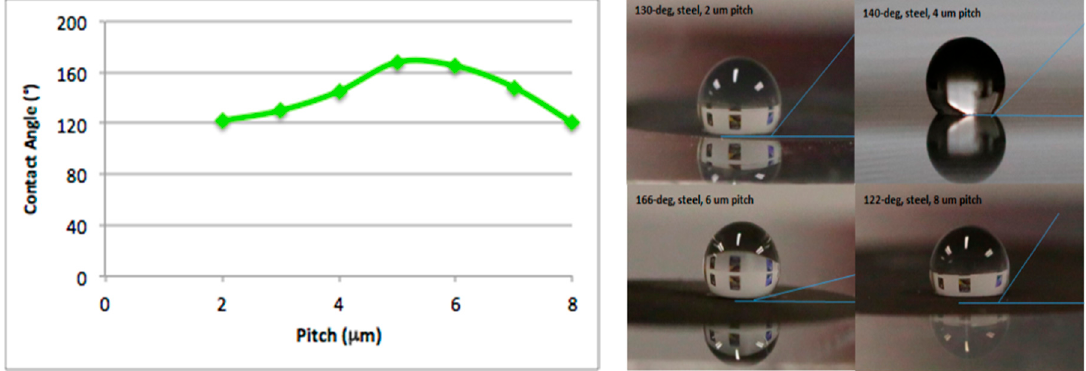
Figure 6. Varying contact angles as a result of different pitches.